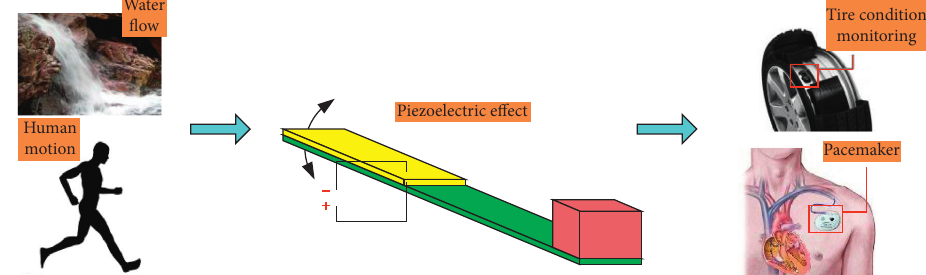
Figure 2: The typical resources for piezoelectric energy harvesting.